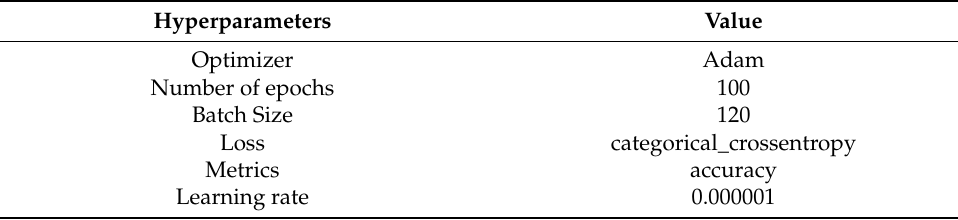
Table 3. Hyperparameter tuning of the proposed convolutional neural network model.